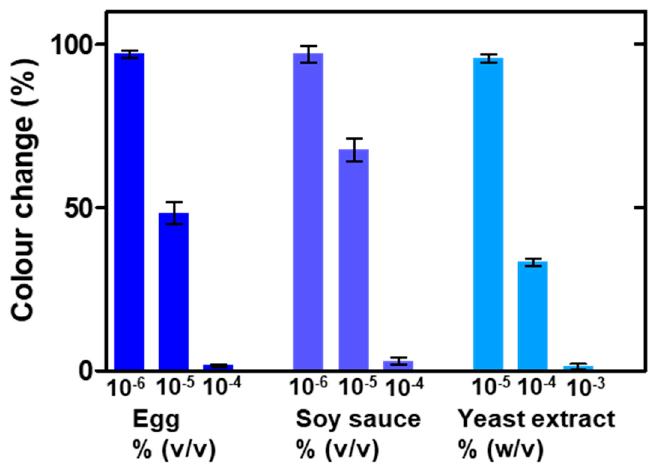
Figure 7. Colour response of the nanoplasmonic paper to different complex samples. Colour shift is defined as the degree of change (expressed as percentage) with respect to the positive control (blank nanoplasmonic paper, 0%) and negative control (pristine paper, 100%) (error bars represent the standard deviation, n = 3).